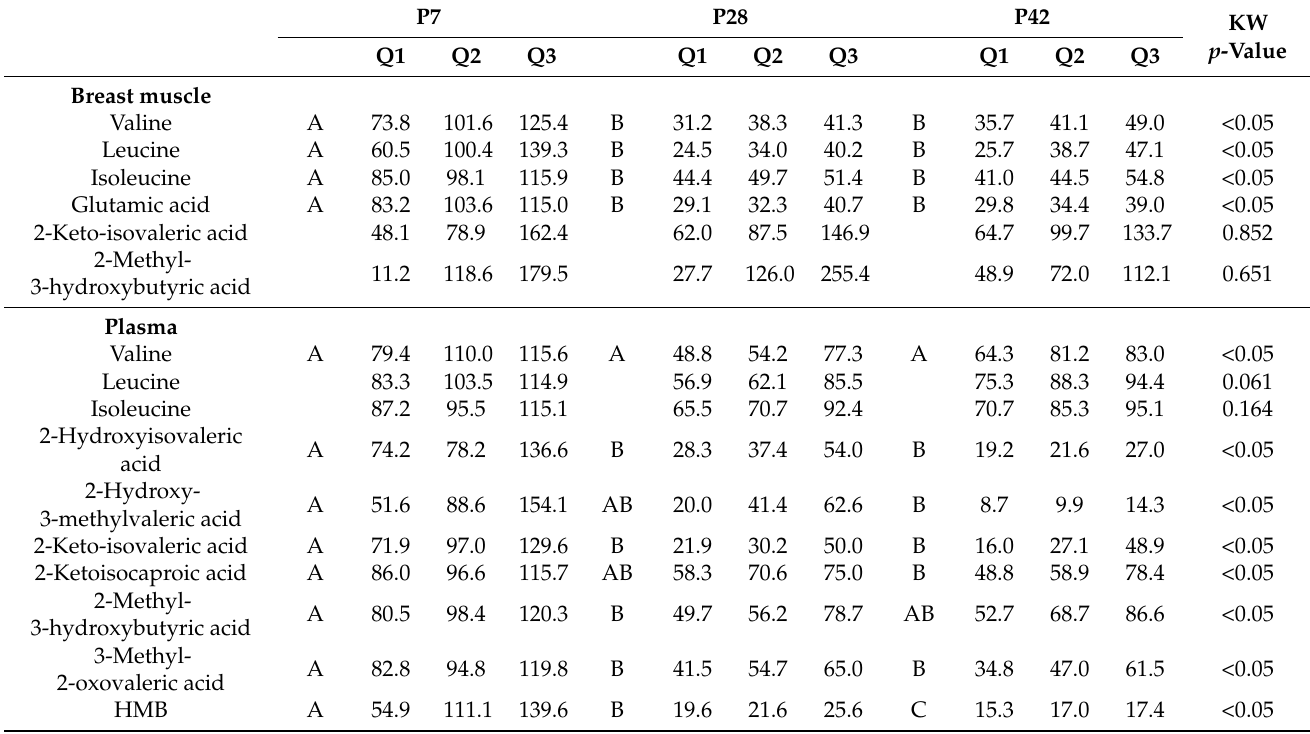
Table 5. Levels of branched-chain amino acids and their metabolites during post-hatch developmental period in chickens.